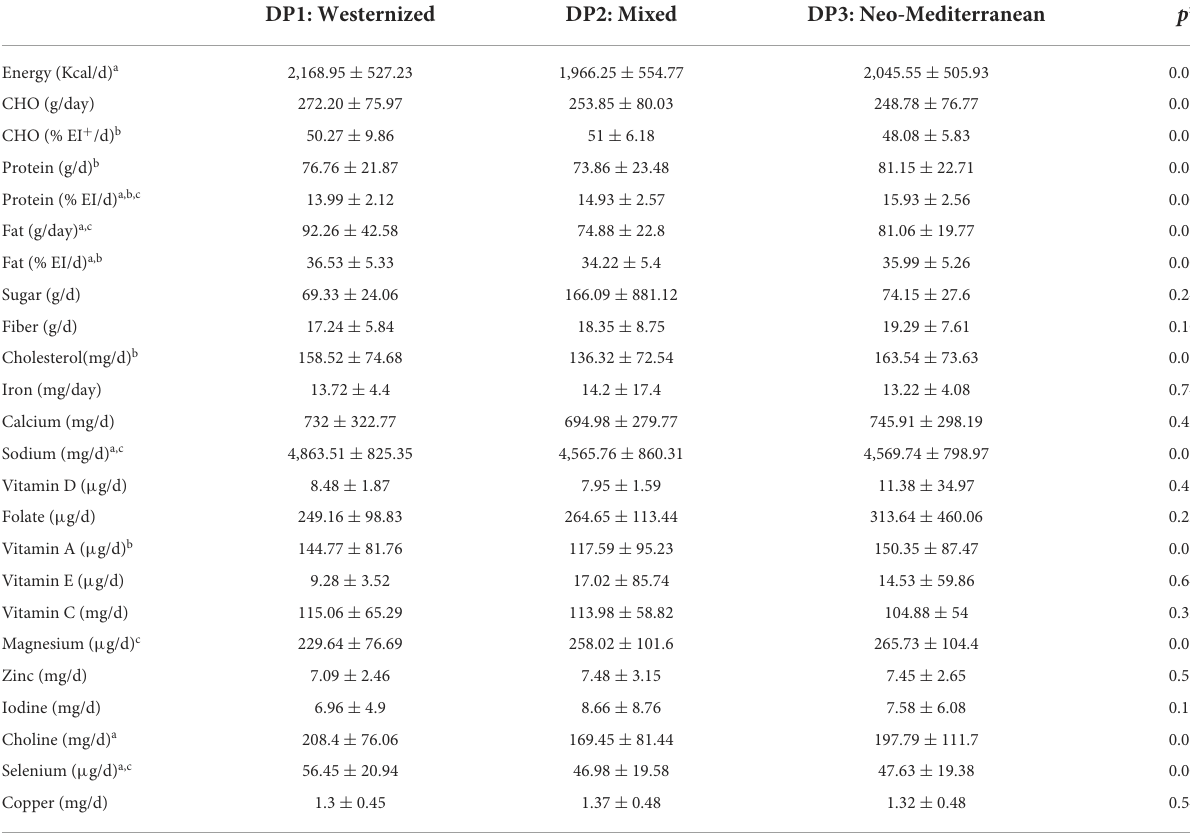
TABLE 7 Energy and nutrients intake of the participants across the three dietary patterns (N = 358). DP1: Westernized DP2: Mixed DP3: